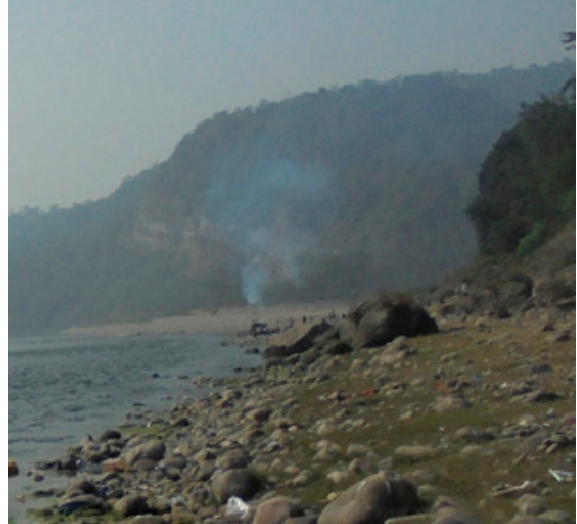
Figure 6. A funeral captured during the field visit in Sujanpur (source: lead author, 2017).